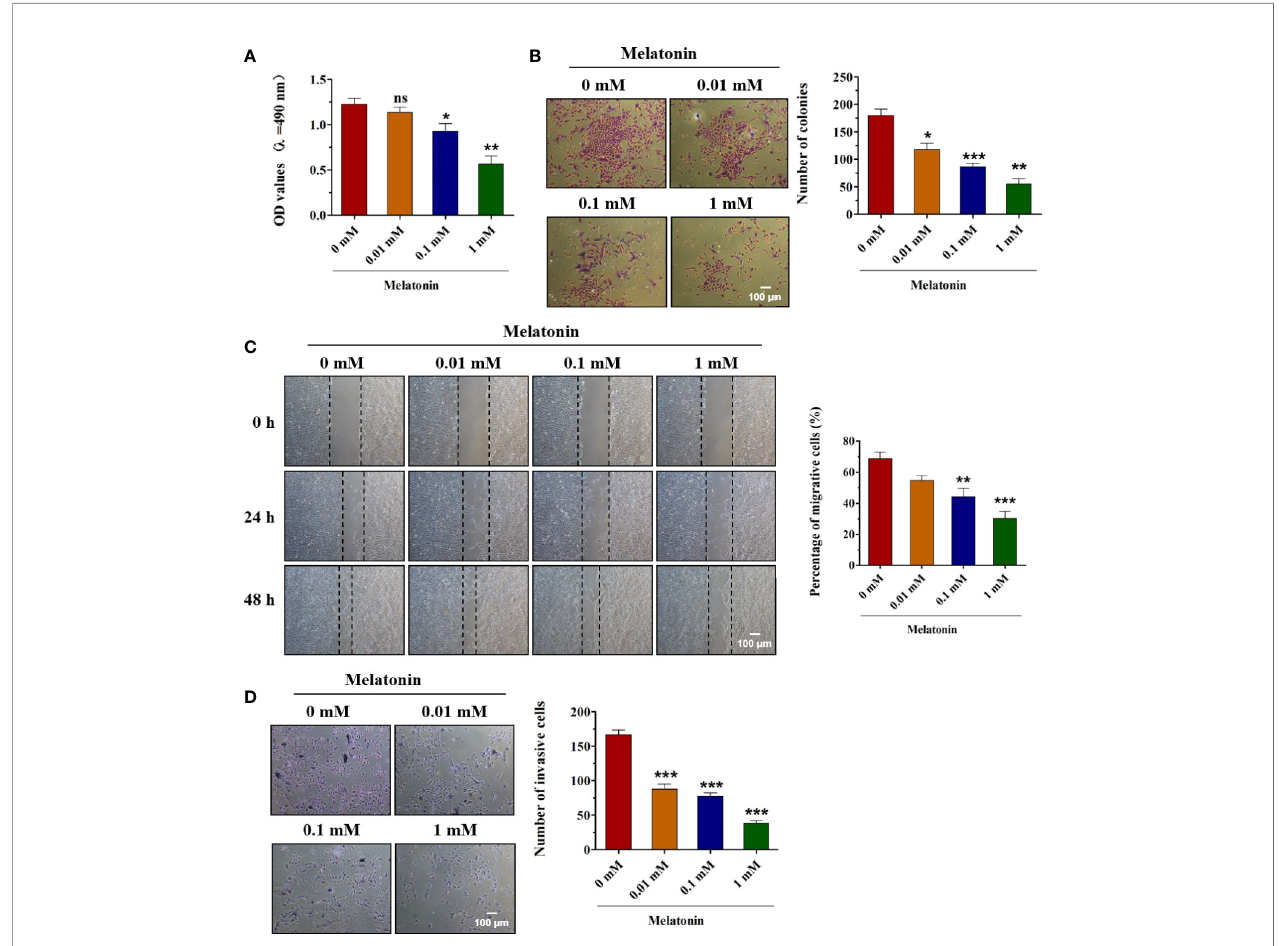
FIGURE 1 | Effects of melatonin on the biological functions of OSCC cells. (A) SCC9 cells were treated with melatonin at 0.01, 0.1, and 1 mM for 48 h, and MTT assay was performed to detect the cell viability. (B) SCC9 cells were exposed to different concentrations of melatonin for 48 h and subjected to colony formation assay to examine the proliferation ability. (C) Effects of melatonin on the migration of SCC9 cells after exposure to melatonin (0.01, 0.1, and 1 mM) for wound healing assay. (D) The invasion ability of SCC9 cells after melatonin treatment by Transwell invasion assay. (n=4, One way ANOVA followed by the Tukey ’ s test, * indicated the differences compared with 0 mM Melatonin group, *p < 0.05, **p < 0.01, ***p < 0.001, ns, no statistical differences, Scale bar, 100 m